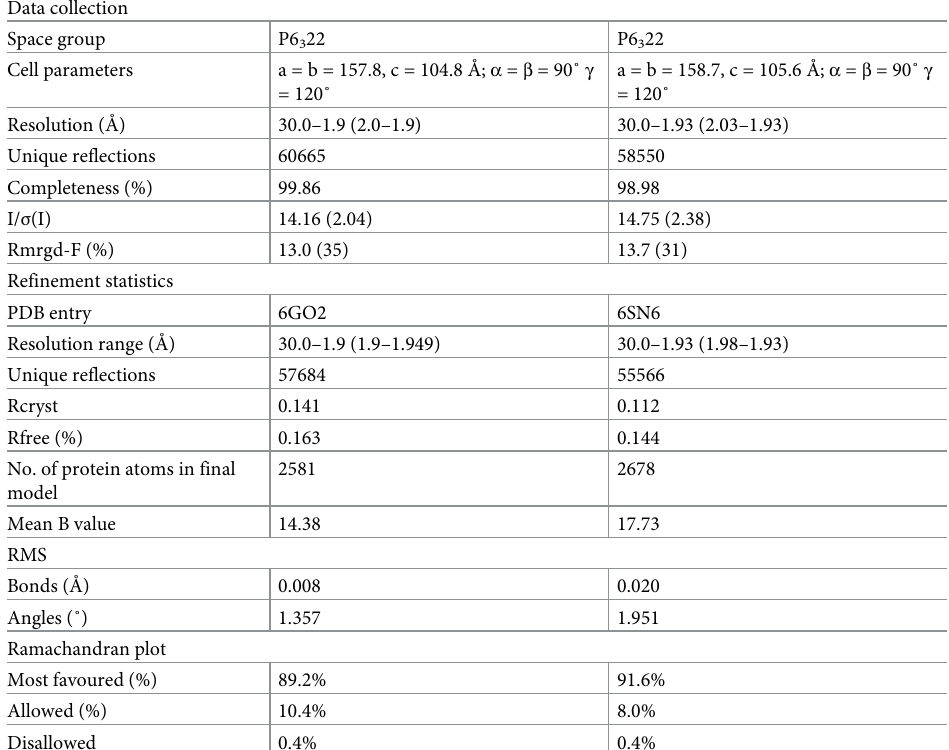
Table 1. Statistical characteristics of experimental data set and refinement of the structure of the CPT–ligand complexes. Data